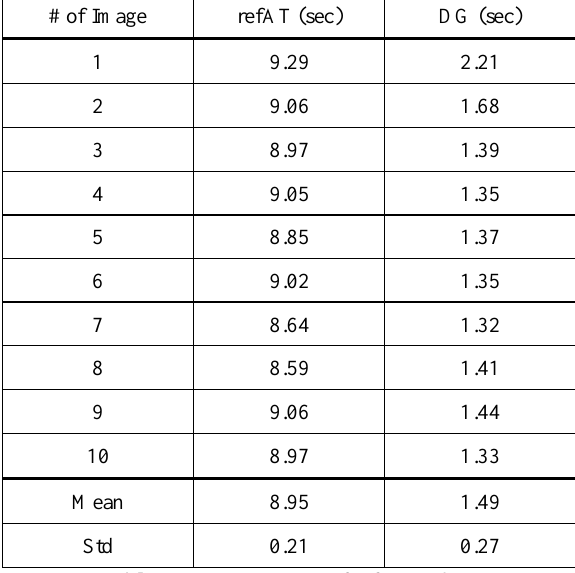
Table 2. Processing time of refAT and